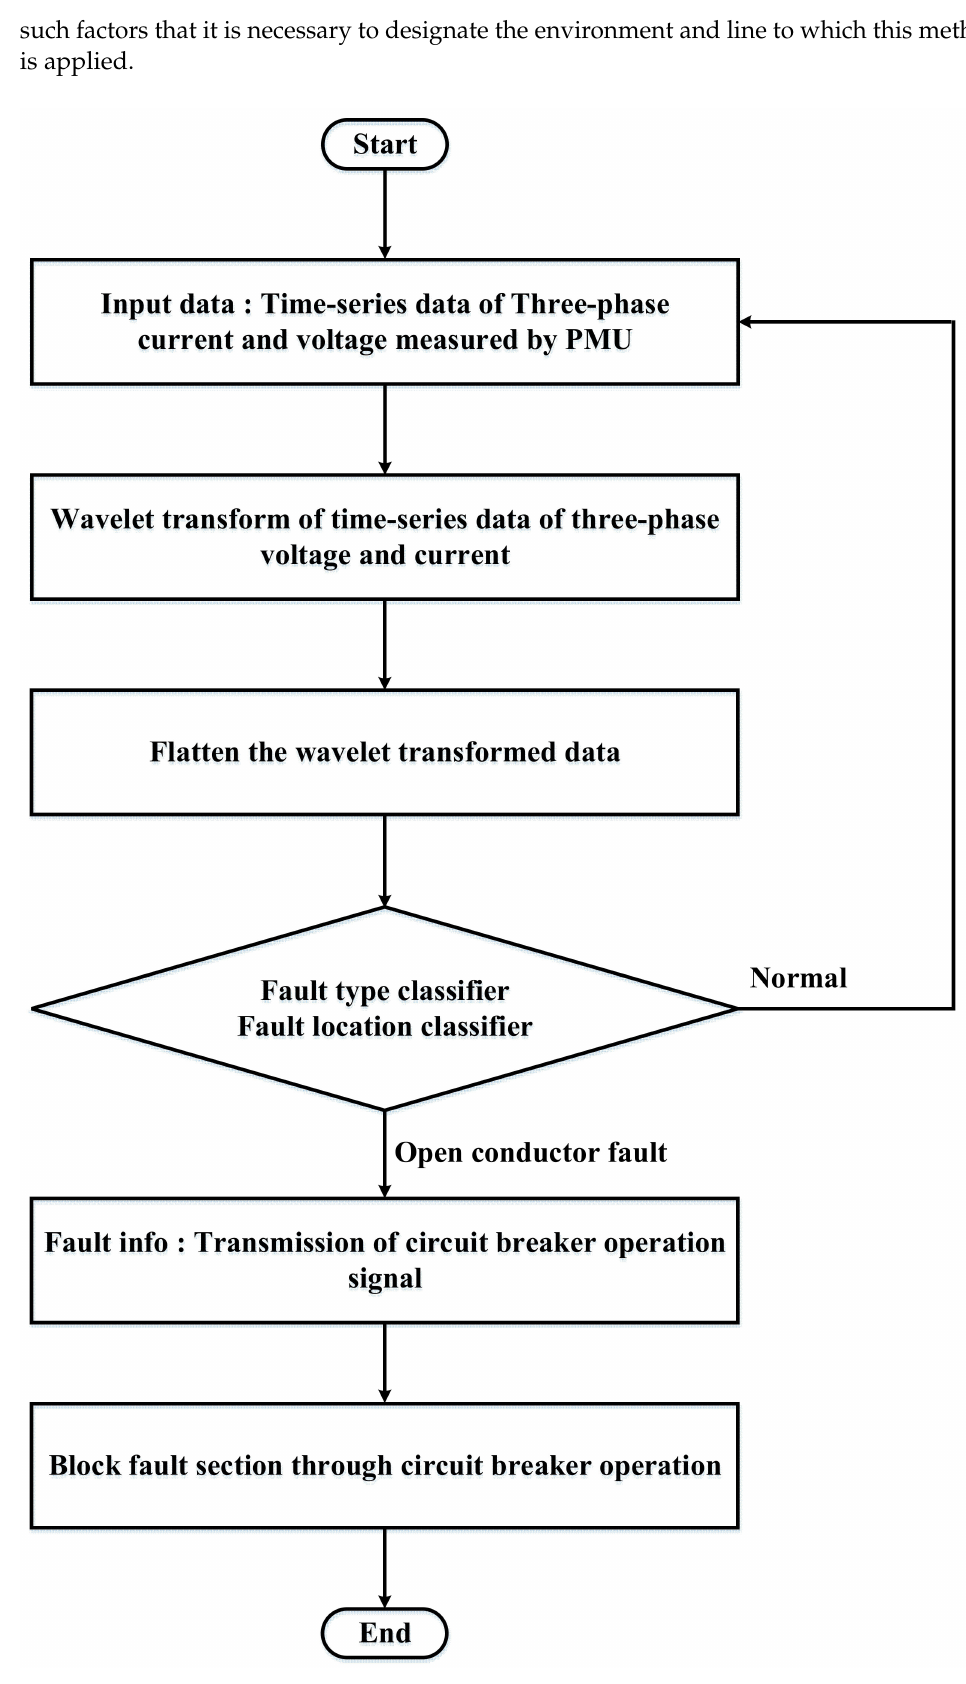
Figure 1. Flowchart of the proposed